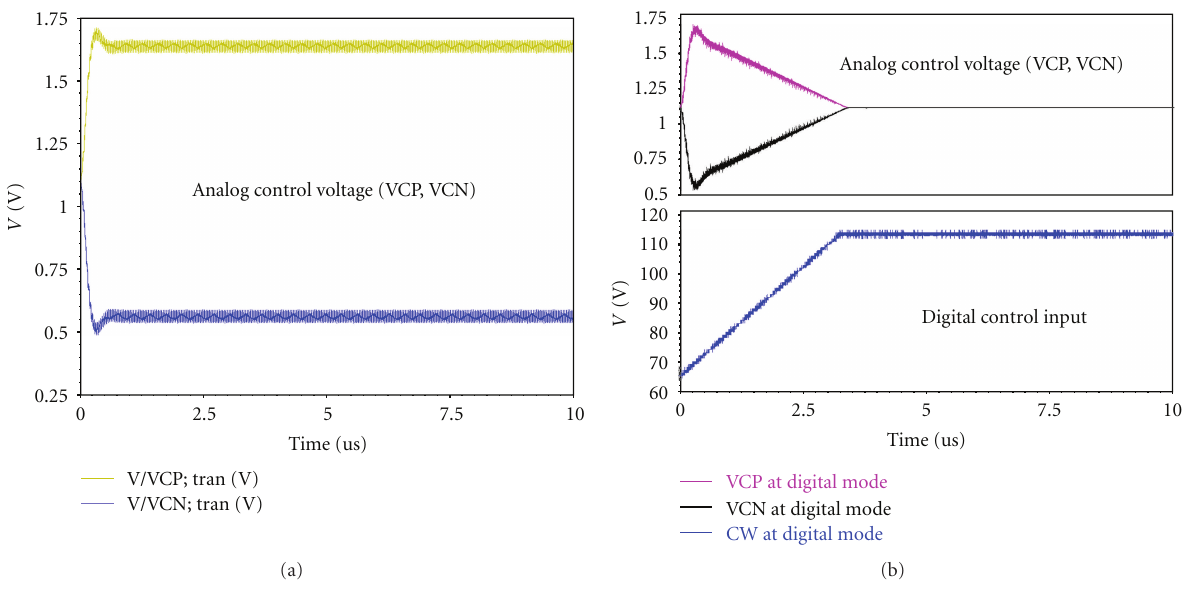
Figure 10: Simulated transient settling voltage: (a) with digital path disabled, and (b) with digital path enabled.